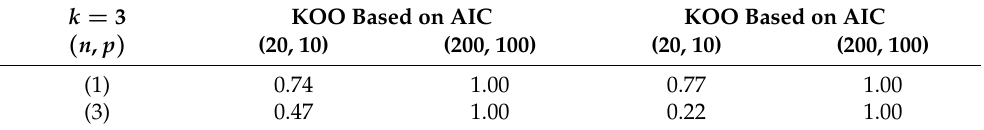
Table 1. KOO Based on